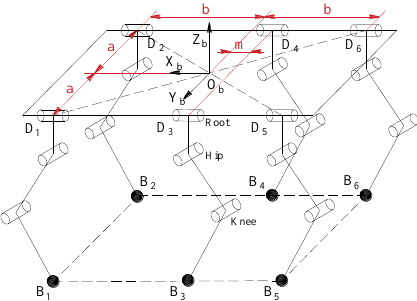
Figure 5. Structure diagram of the hydraulic hexapod robot (HHR).